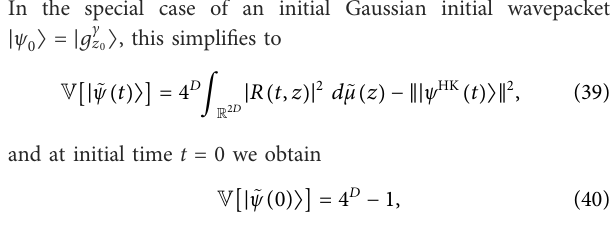
Algorithm 1 relies on the discretisation of the phase-space integrals and of the system of ordinary differential